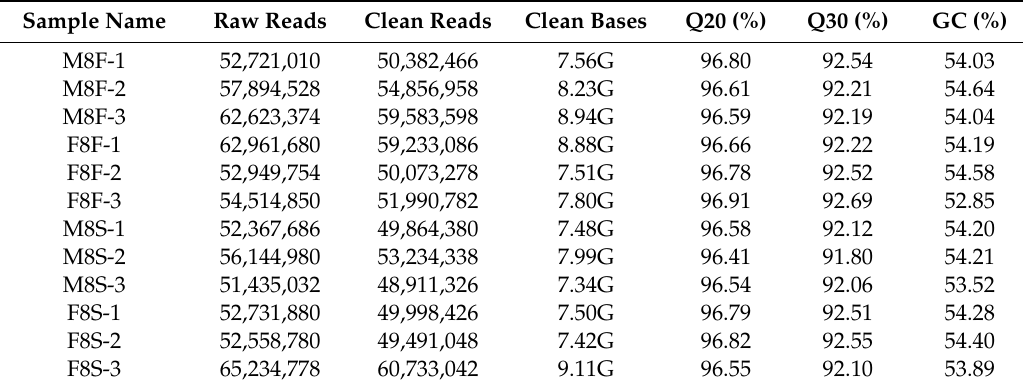
Table 4. Data quality from sequencing the eight-week-old